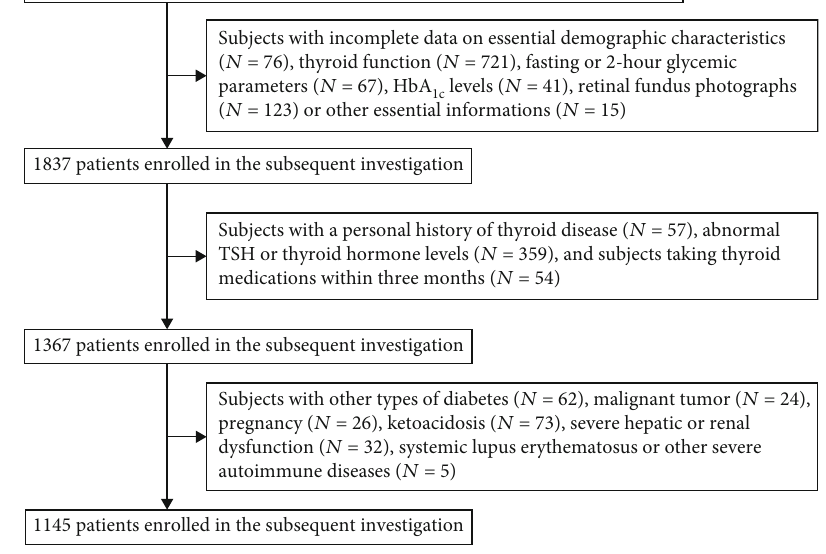
Figure 1: The screening process of the